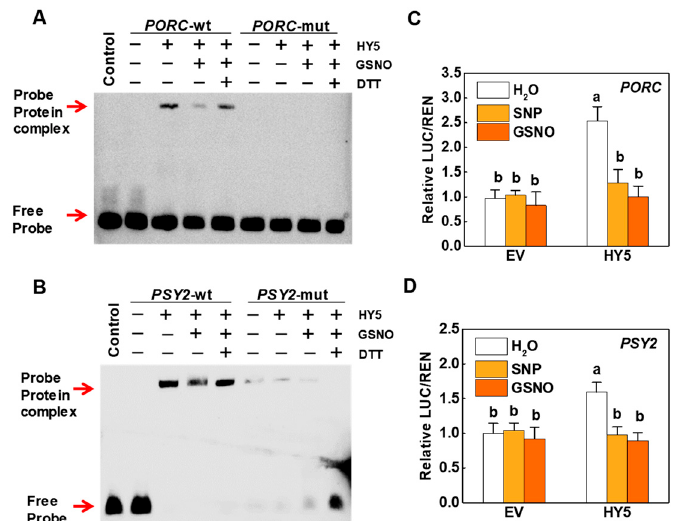
Figure 5. NO suppressed interaction between HY5 and the promoters of PORC and PSY2 . ( A , B ) EMSA assay. After 30 min of incubation with or without 250 μ M GSNO, the His ‐ HY5 recombinant protein was incubated with biotin ‐ labeled wild ‐ type (wt) or mutant (mut) PORC and PSY2 oligos. The protein purified from the empty vector was used as a negative control. DTT was used as a reducing agent. ( C , D ) The regulatory effects of HY5 on the promoters of PORC and PSY2 as determined by dual ‐ luciferase assay. Tobacco ( Nicotiana benthamiana ) leaves were infiltrated, and firefly LUC and Renilla LUC were assayed 3 days after infiltration. The LUC/REN ratio of the empty vector (EV) plus promoter treated with H 2 O was set as 1. Data are shown as means ± SD ( n = 6). Different letters indicate significant differences at p < 0.05 according to Tukey’s test.